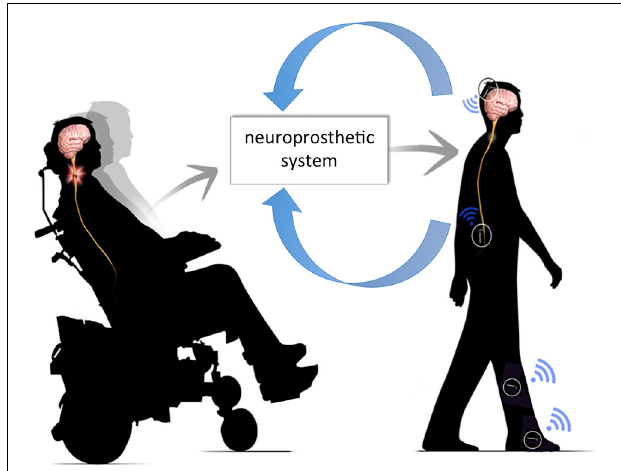
FIGURE 1 | Neuroprosthetic system. The neuroprosthetic system is capable of interpreting volitional movement signals from the brain, integrating these commands with sensor feedback (e.g., joint angle, limb velocity, etc.) and, delivering appropriate commands into intact neural circuitry below the level of